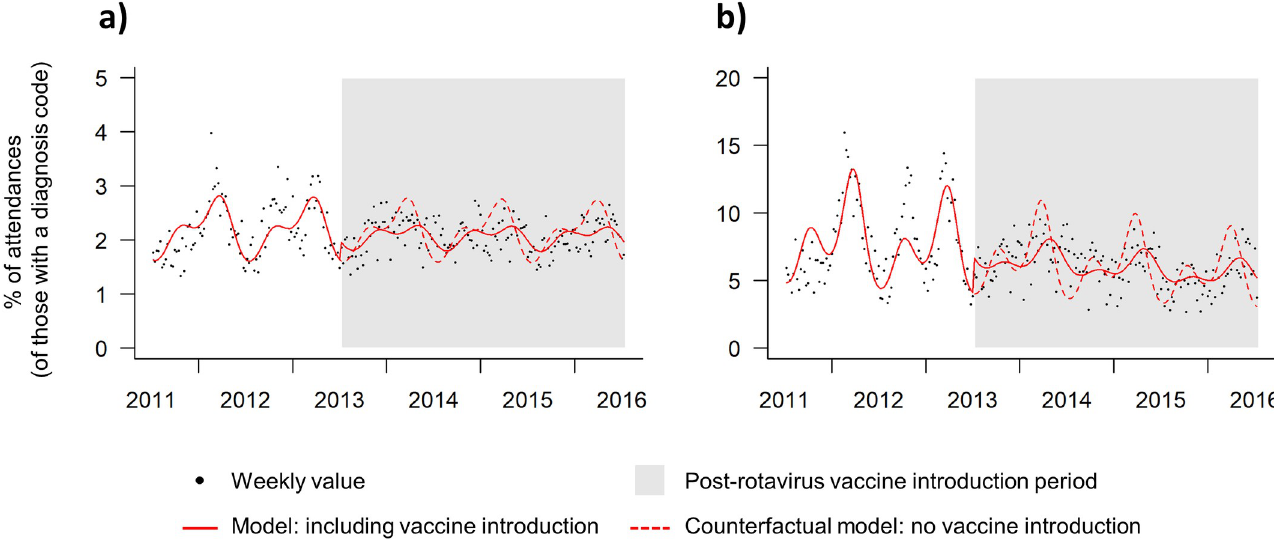
Fig 2. Weekly emergency department (ED) gastroenteritis visits, interrupted time-series regression model with level change and harmonic adjustment for seasonality, a) all ages and b) young children (0–4 years), week 27 2011 to week 26 2016 (grey box represents the rotavirus vaccine period).